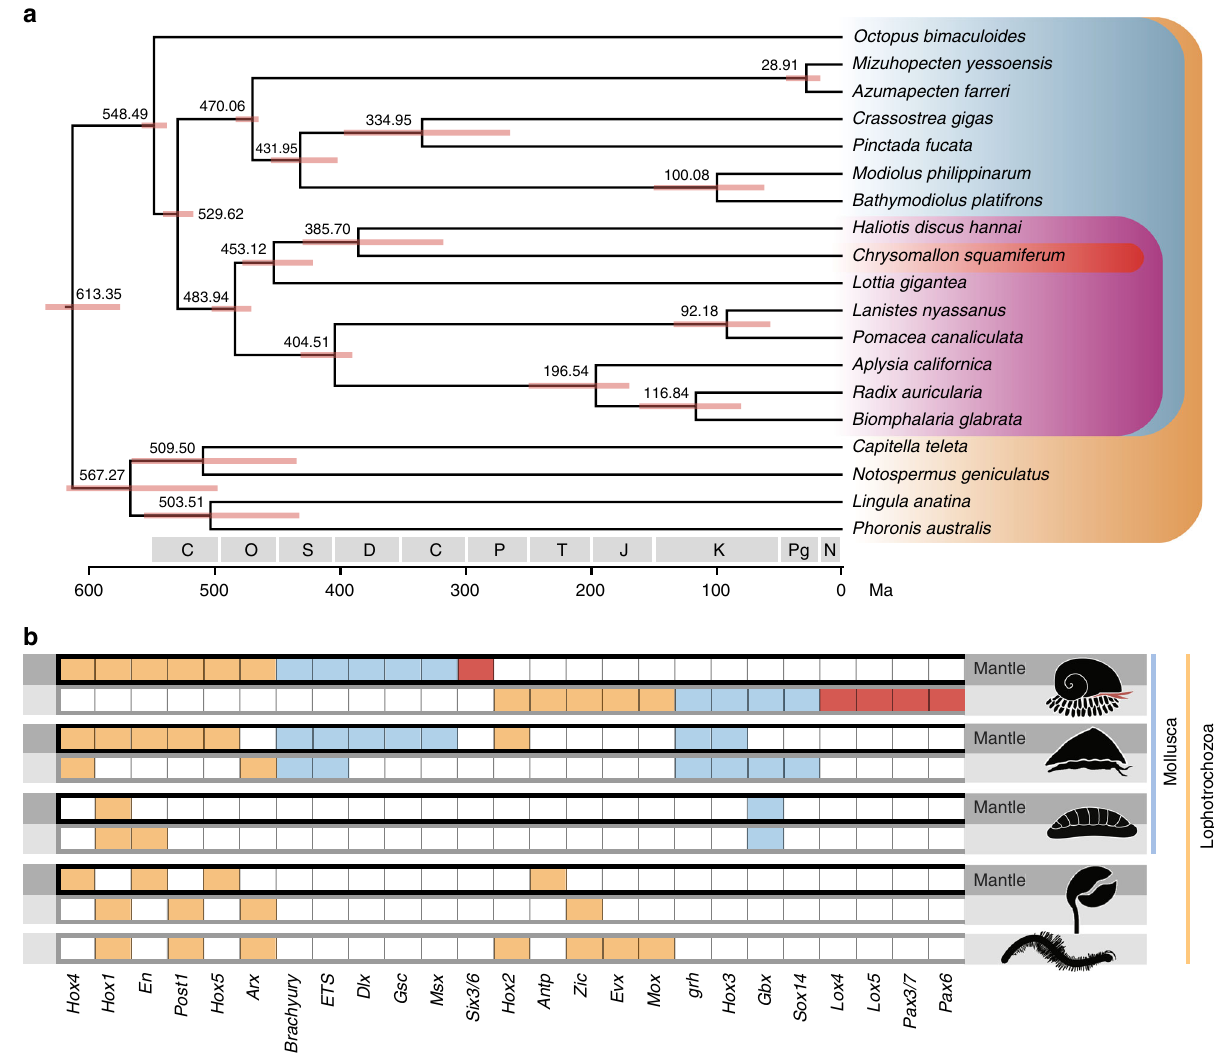
Fig. 6 Genomic and transcriptomic comparisons across Lophotrochozoa and the biomineralisation toolkit. a Genome-based phylogeny of selected taxa showing the position of the Scaly-foot Snail among lophotrochozoans and divergence times among molluscan lineages. Error bars indicate 95% con fi dence levels. The Scaly-foot Snail is highlighted in red, Gastropoda in pink, Mollusca in blue, and Lophotrochozoa in orange. b Transcription factors shown to be involved in armature secretion in the Scaly-foot Snail, compared with conchiferan molluscs (bivalves, gastropods, cephalopods), aculiferan molluscs (chitons), brachiopod, and annelids. Transcription factors only veri fi ed for the Scaly-foot Snail are highlighted in red, those known to be shared across Mollusca in blue, and those shared across Lophotrochozoa in orange. The top row for each group (darker shading) shows records of signi fi cant expression in shell-secreting mantle and bottom row (lighter shading) shows expression for other hard parts such as scales. Ma, million years ago. Source data are provided as a Source Data fi